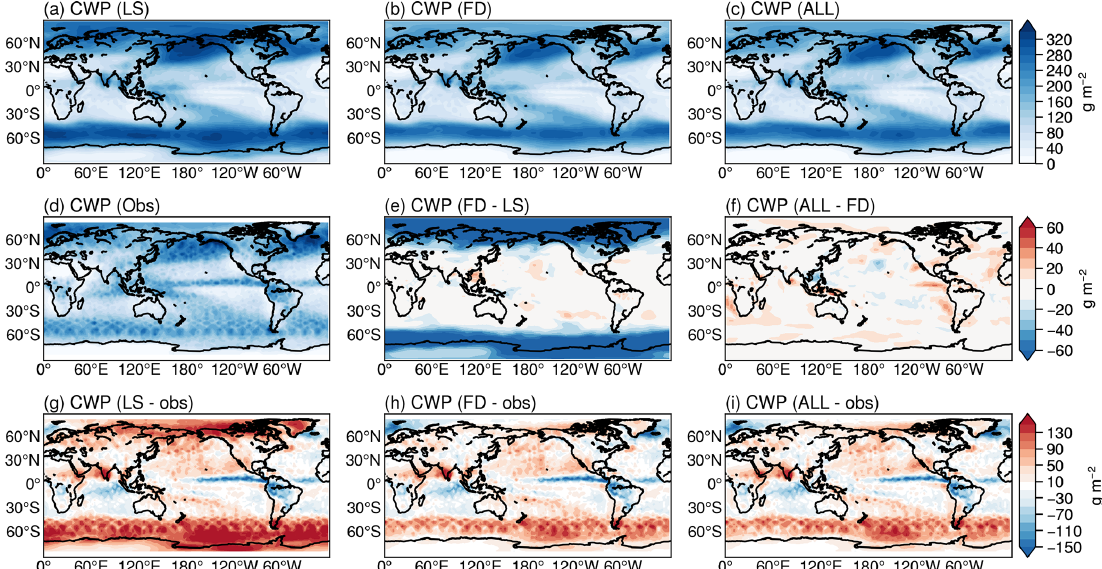
Figure 9. The same as Fig. 7 but for the spatial patterns of total cloud water path (CWP; gm − 2 ). The observed climatology of CWP is derived from the CloudSat data set.